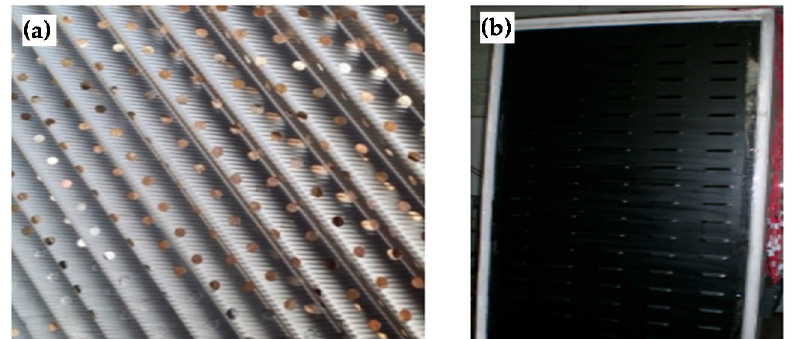
Figure 2. Structure of the ( a ) perforating corrugated plate and ( b ) slit-perforated plate.